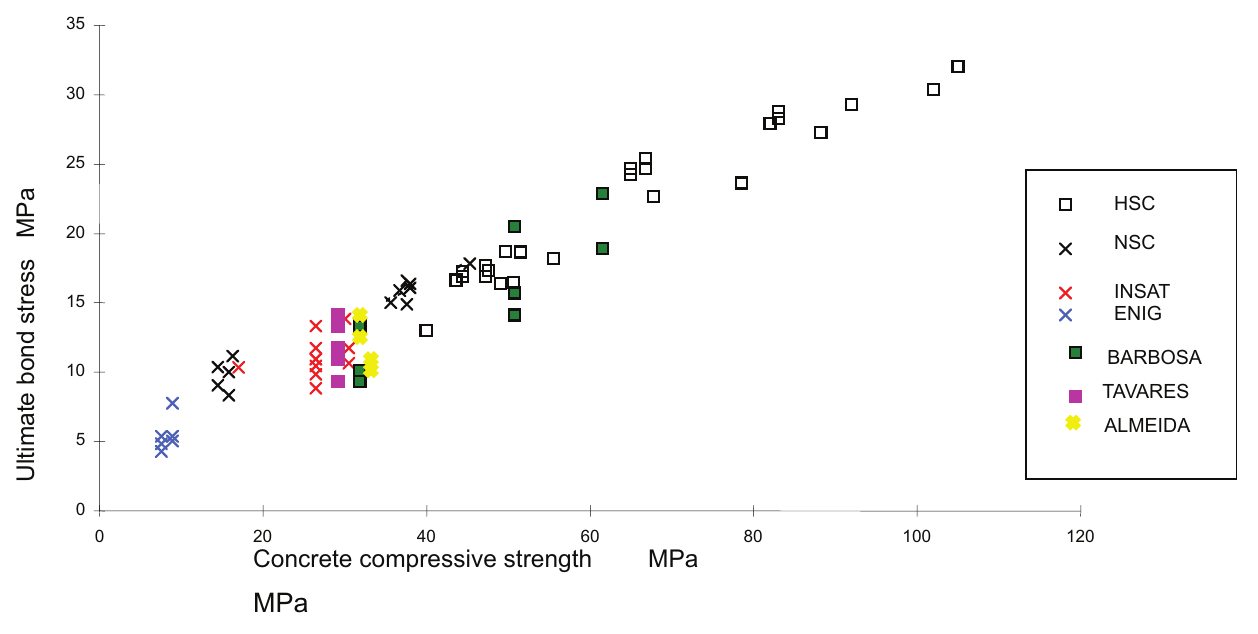
Figura 6 – Updated bond stress/compressive strength relationship data gathered in the current